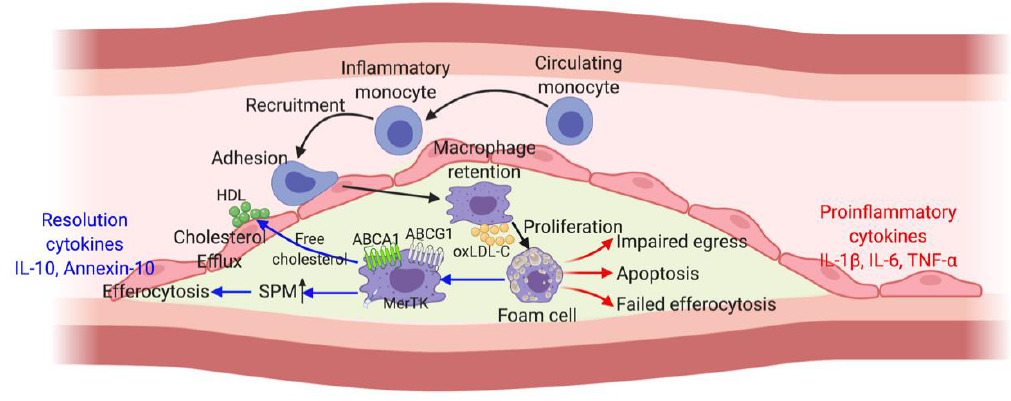
Figure 2. Role of macrophages in atherosclerosis.